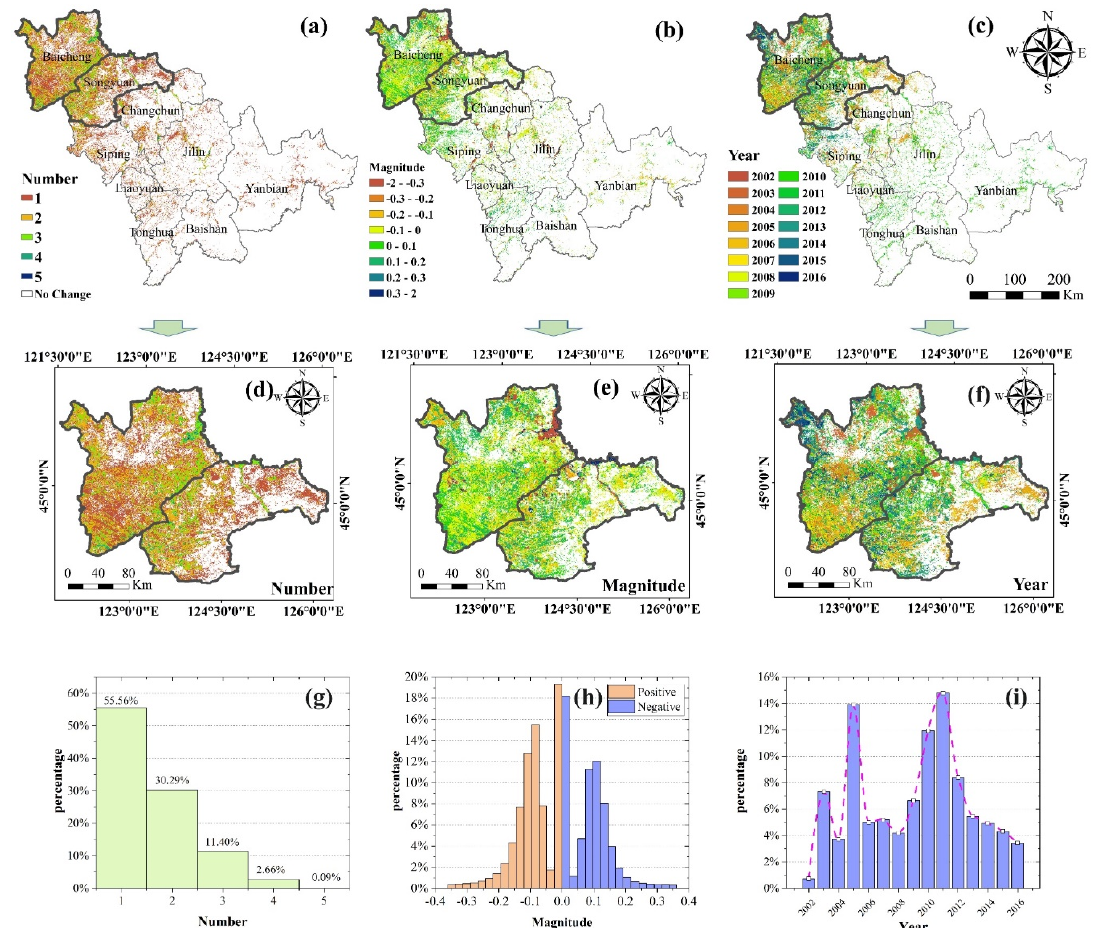
Figure 5. Abrupt change of the NDVI time series in Jilin Province during 2000–2018: ( a ) spatial distribution of the number of changes; ( b ) spatial distribution of the magnitude of change; ( c ) spatial distribution of the year of change; ( d – f ) spatial disturbance of the number, magnitude, and year in Baicheng and Songyuan, respectively; ( g ) area percentage of the number of changes; ( h ) area percentage of the magnitude of change; ( i ) area percentage of the year of change.